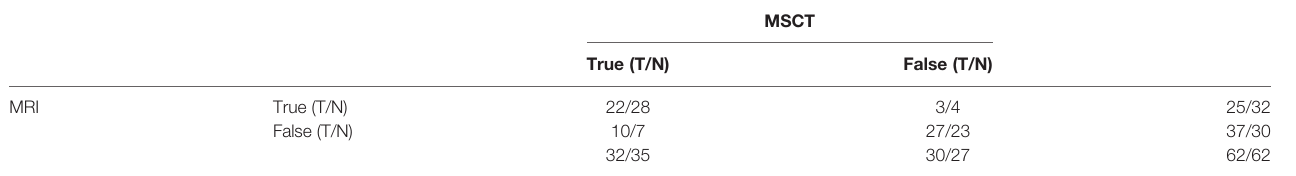
TABLE 4 | Comparison of accuracy between MSCT and MRI for T/N restaging of rectal cancer after